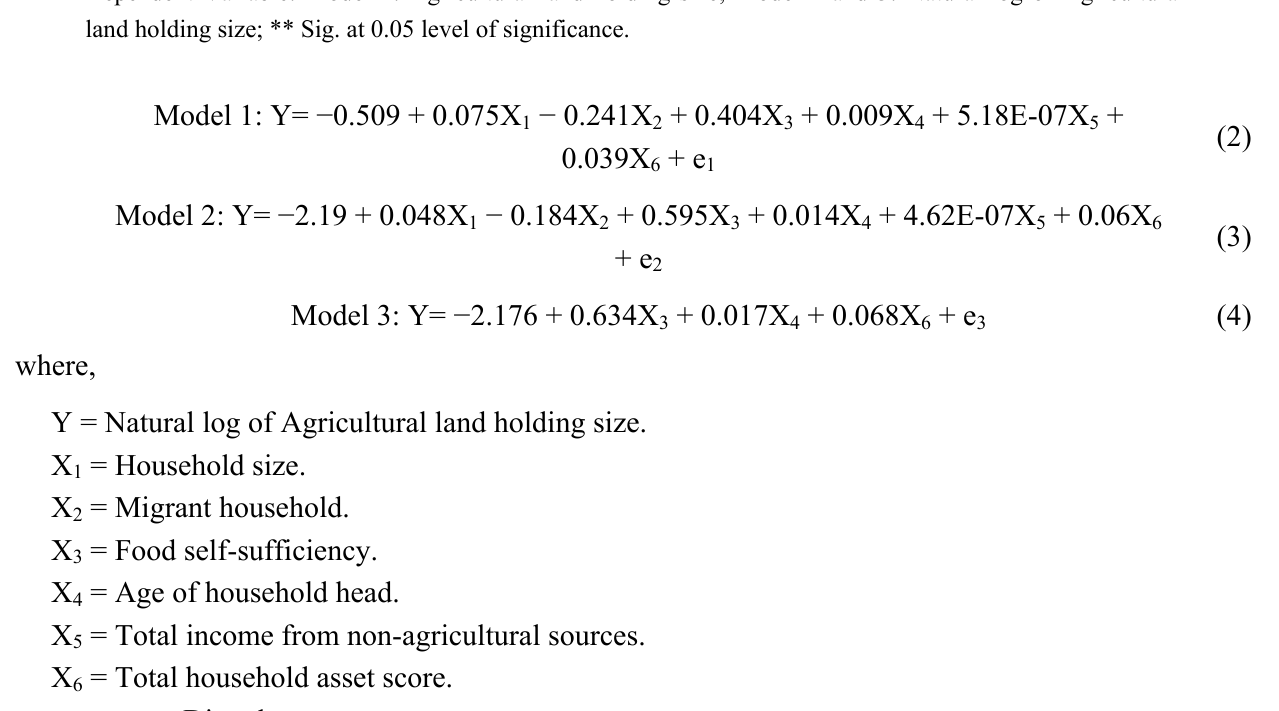
Table 3. Determinants of agricultural landholding (n = 131). Source: Household survey 2009. Model 1 (Before Model 2 (After Model 3 (After Transformation) Transformation) Transformation) Variables Coefficients p Coefficients p Coefficients p (Constant) − 0.509 ** 0.022 − 2.19 0.000 − 2.176 0.000 Household size 0.075 ** 0.004 0.048 0.120 Migrant household − 0.241 ** 0.042 − 0.184 0.201 Food self-sufficiency 0.404 ** 0.000 0.000 Age household head 0.009 ** 0.013 0.000 Total income from 5.18 × 10 − 7 ** 0.009 4.62 × 10 − 7 0.057 non-agric. Sector Total household asset score 0.039 ** 0.034 R-Square 0.434 Adjusted R-Square